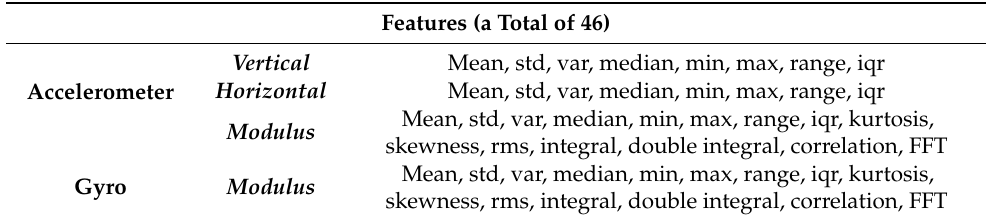
Table 4. Motion detection features selected for the XGBoost.